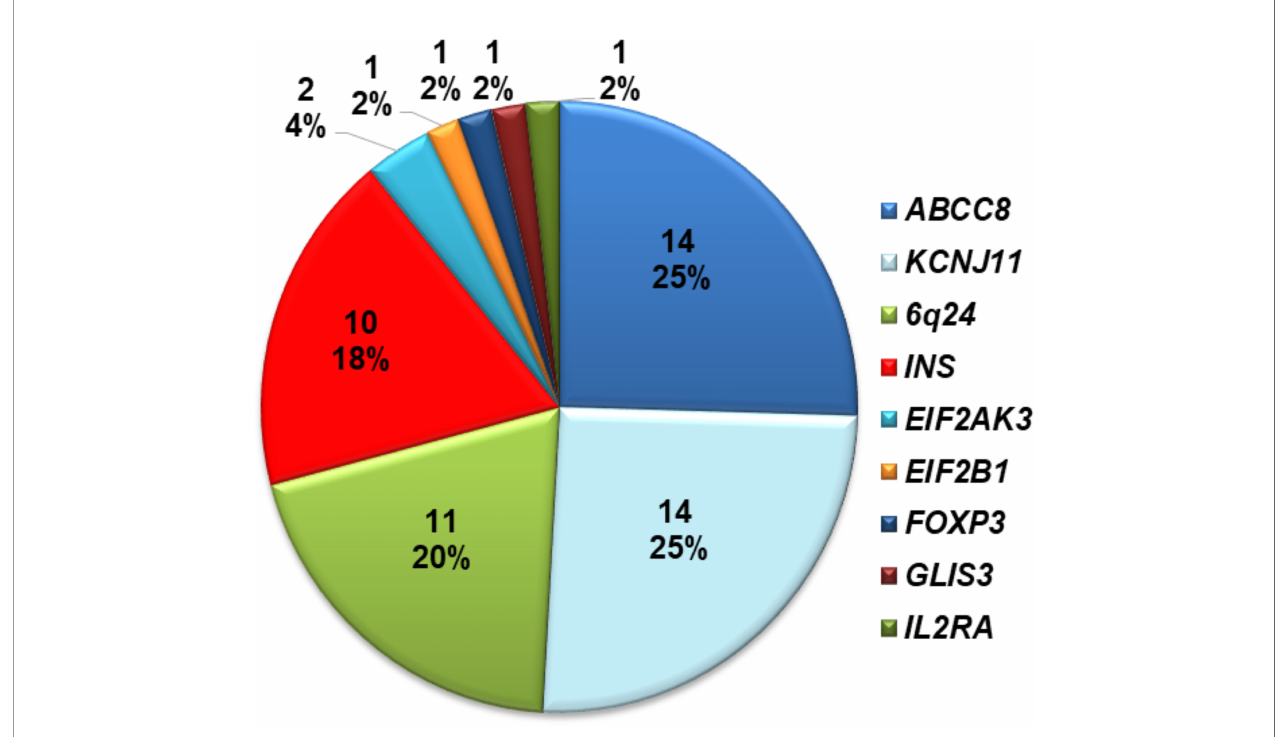
FIGURE 1 | Distribution of mutations identi fi ed in 70 Vietnamese patients with diabetes diagnosed before 1 year of